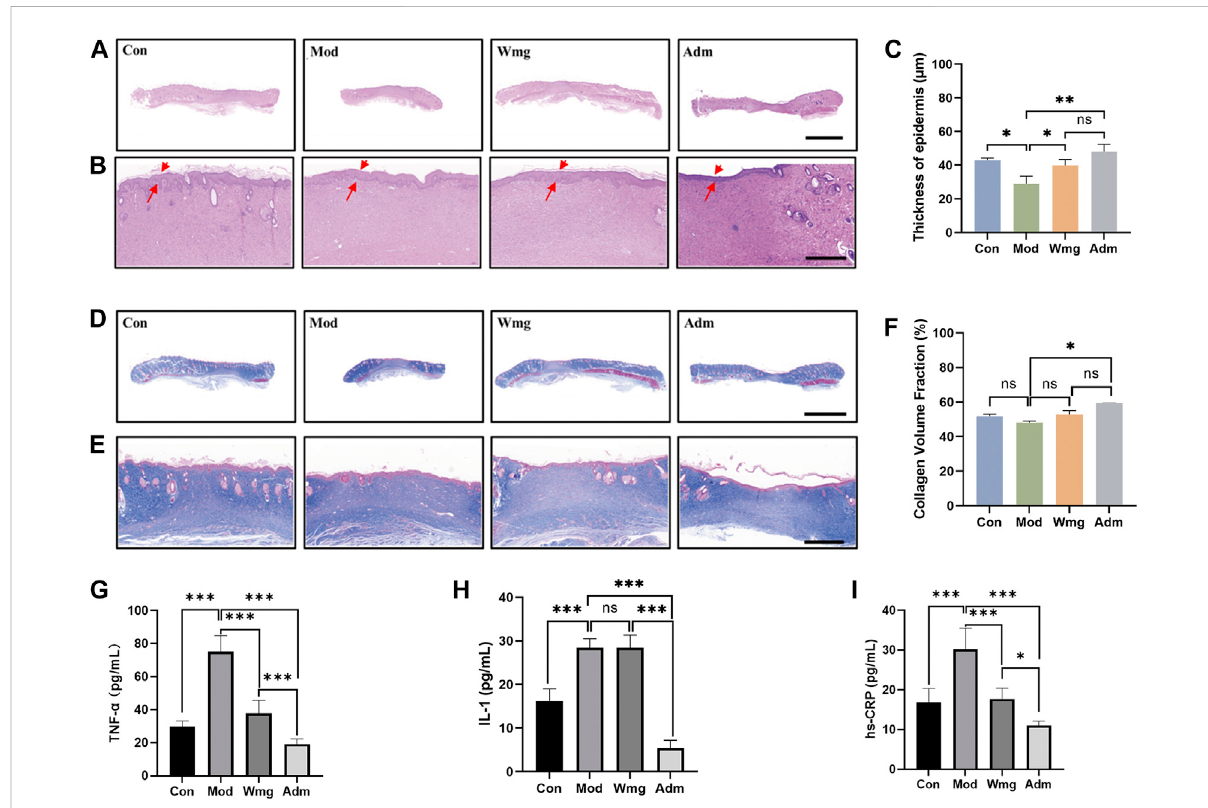
FIGURE 4 H & E staining, Masson staining and cytokine assay of different groups of wound tissues. (A – B) Representative images of wound sections with H & E staining on day 28 (scale bar = 5 mm, scale bar = 500 μ m). Red arrow indicates regenerating epidermis. (C) Thickness of epidermis (* p < 0.05, ** p < 0.01 and*** p < 0.001). (D – E) Representative images ofwoundsectionswithMasson ’ strichrome stainingonday28(Masson ’ strichrome:scale bar = 5 mm, scale bar = 1,000 μ m). The blue colored ones are collagen fi bres and collagen bundles, and the red ones are muscle fi bres.